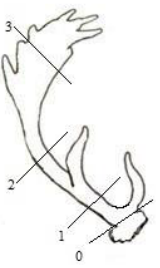
Figure 1. Places where samples 1 – 3 were obtained from individuals aged 3 – 8 years, 0 — place where the antlers were cut.